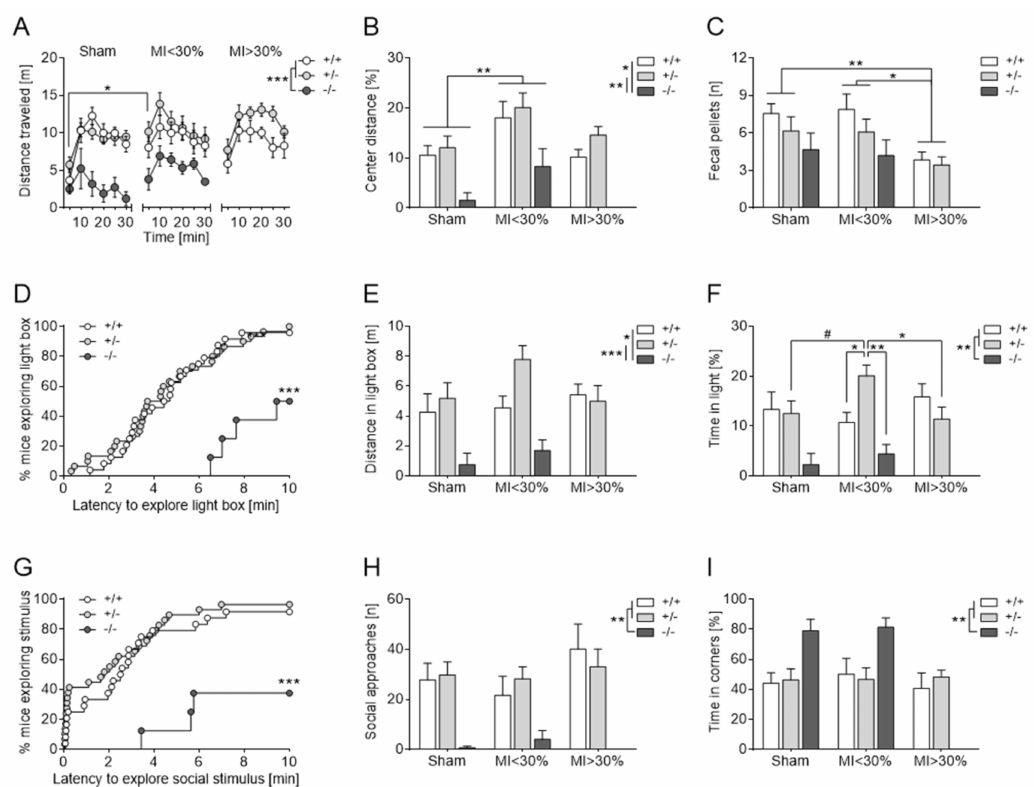
Figure 6. Distinct behavioral phenotype of 5-HTT deficient mice in multiple approach-avoidance conflict tests. ( A – C ) During the 30-min open field test (OFT), 5-HTT − / − traveled significantly shorter distances than the other two 5-Htt genotypes in the entire arena ( A ) and in the center ( B ). Furthermore, MI < 30% were more active than sham animals during the first 2 min of the OFT ( A ) and covered cumulatively longer distances in the center of the arena as compared to sham controls ( B ). Interestingly, MI > 30% deposited less fecal pellets in the OF than MI < 30% and sham animals ( C ). ( D , E ) In the dark-light box (DLB), half of the 5-HTT − / − mice refrained from exploring the bright section ( D ). Furthermore, 5-HTT − / − mice covered shorter distances ( E ) and spent cumulatively less time in the light chamber ( F ) as compared to 5-HTT+/ − and 5-HTT+/+ mice. Additionally, 5-HTT+/ − mice with small infarcts (MI < 30%) spent significantly more time in the light compartment of the DLB than 5-HTT+/ − mice of the other two groups as well as 5-HTT+/+ and 5-HTT − / − mice with MI < 30% ( F ). ( G – I ) In the social interaction test (SIT), only 3 out of 8 5-HTT − / − mice explored the unfamiliar stimulus mouse at least once ( G ). The number of social approaches was significantly decreased ( H ) while the cumulative time in opposite corners was dramatically increased (I) in 5-HTT null mutants compared to the other two 5-Htt genotypes. Data are shown as mean ± SEM. # p < 0.1, * p < 0.05, ** p < 0.01 and *** p < 0.001; three-way mixed ANOVA followed by Sidak or Tukey multiple comparisons test; ( D , G ) log-rank